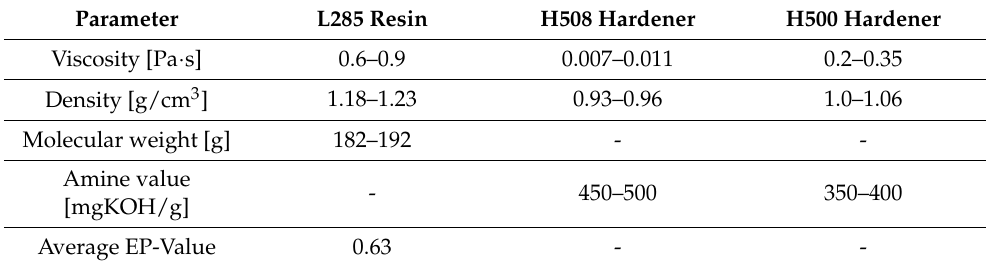
Table 1. Chemical specification of epoxy resin and hardeners (25 ◦ C), see